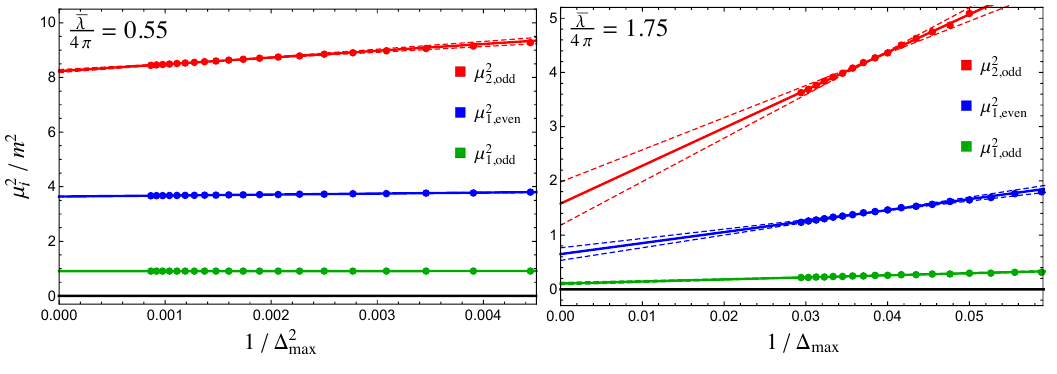
Figure 3 . Two examples of the dependence of (cid:22) 2 (green), (cid:22) 2 (blue), and (cid:22) 2 (red) on 1 ; even 1 ; odd 2 ; odd (cid:1) max , at (cid:12)xed (cid:22) (cid:21) = 0 : 55 (left) and (cid:22) (cid:21) = 1 : 75 (right). The solid lines show the best (cid:12)t for each 4 (cid:25) 4 (cid:25) (cid:22) 2 ((cid:1) max ) to the functional form in eq. (4.2), with the resulting powers n = 2 : 0 (left) and n = 1 : 0 i (right). The y -intercept for each (cid:12)t provides the extrapolated value of (cid:22) 2 for (cid:1) max ! 1 , and the i error is estimated by varying the slope by 15% about the mean of the data